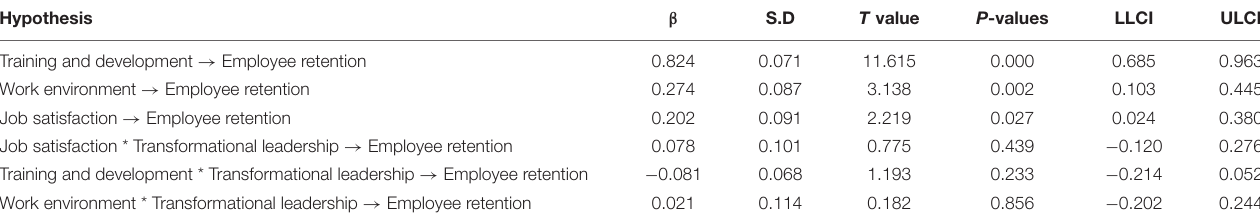
TABLE 3 | Hypotheses